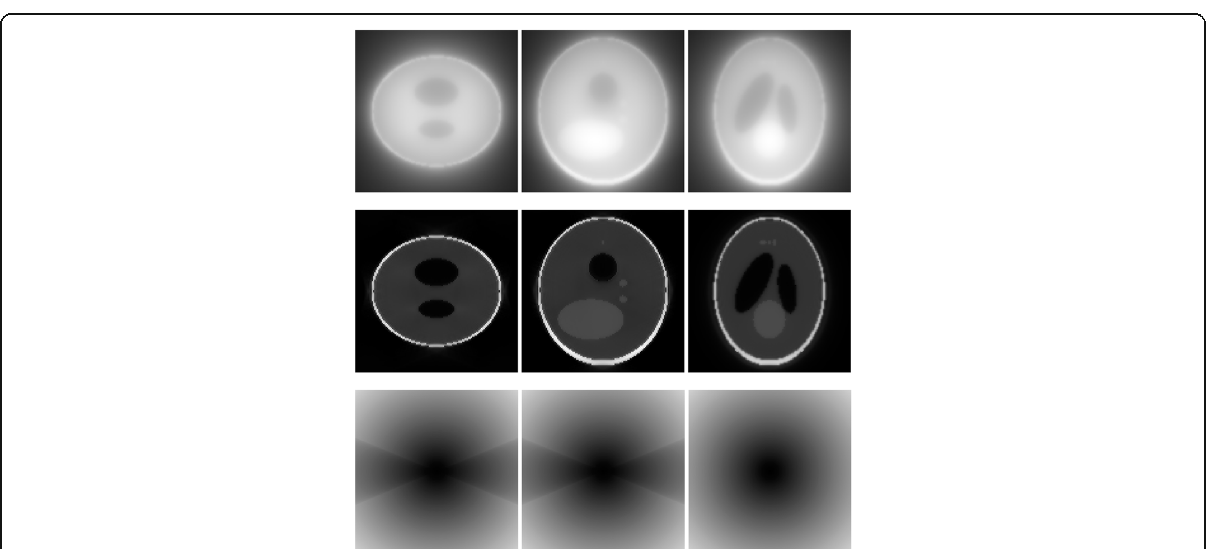
Fig. 17 Image reconstruction using non-TOF algorithm for the case of ψ = 3 π /8. Row 1 : TOF backprojection. Row 2 : Final reconstruction. Row 3 : Tomographic filter H . Three central orthogonal cuts are shown for each